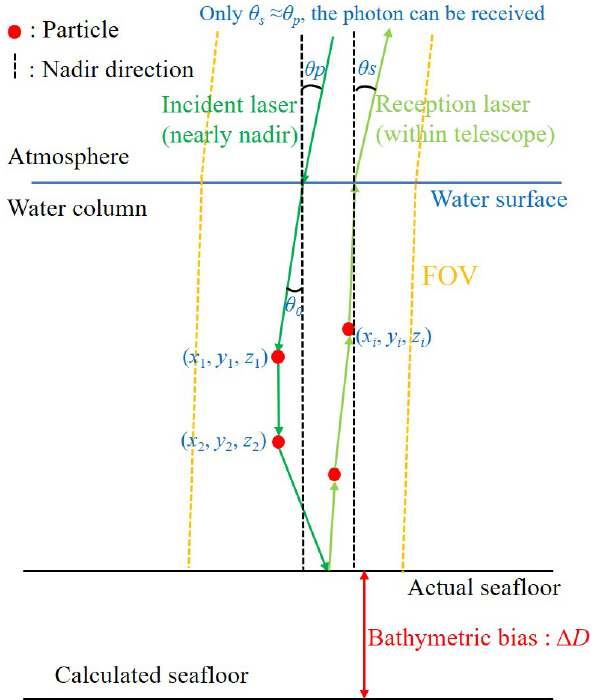
Figure 1. Schematic diagram of the influence of the water forward scattering in lidar bathymetry. θ p is the incident laser nadir angle on the water surface from the lidar; θ s is the zenith angle of photon packets leaving the water surface back to the lidar; θ 0 is the laser nadir angle entering the water column; and ( x i , y i , z i ) are the photon packet coordinates after the i -th interaction with particles. Note that only the photon packets whose coordinates are within the field of view (FOV) can be received by the lidar telescope. ∆ D is the bathymetric bias due to the water forward-scattering effect, i.e., the length difference between the broken lines of the laser path with scattering and the straight line without